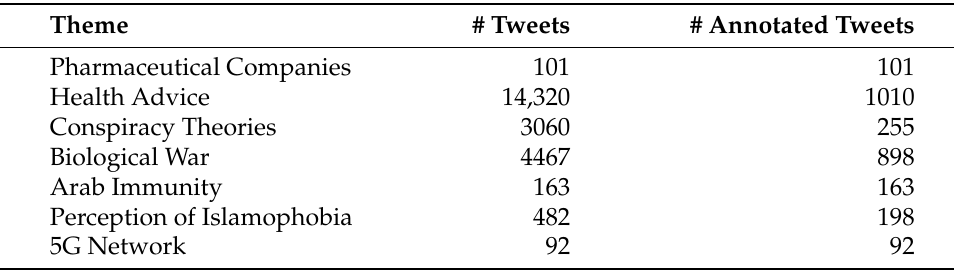
Table 3. Misinformation